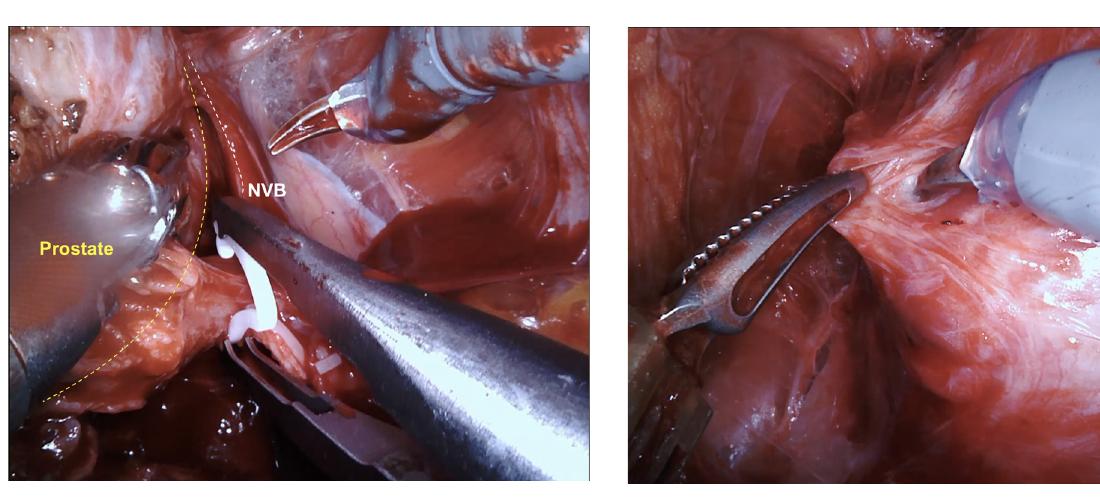
Figure 5 - Connection between the anterior and posterior planes to isolate and ligate the prostatic pedicle with hem- o-lok clips.